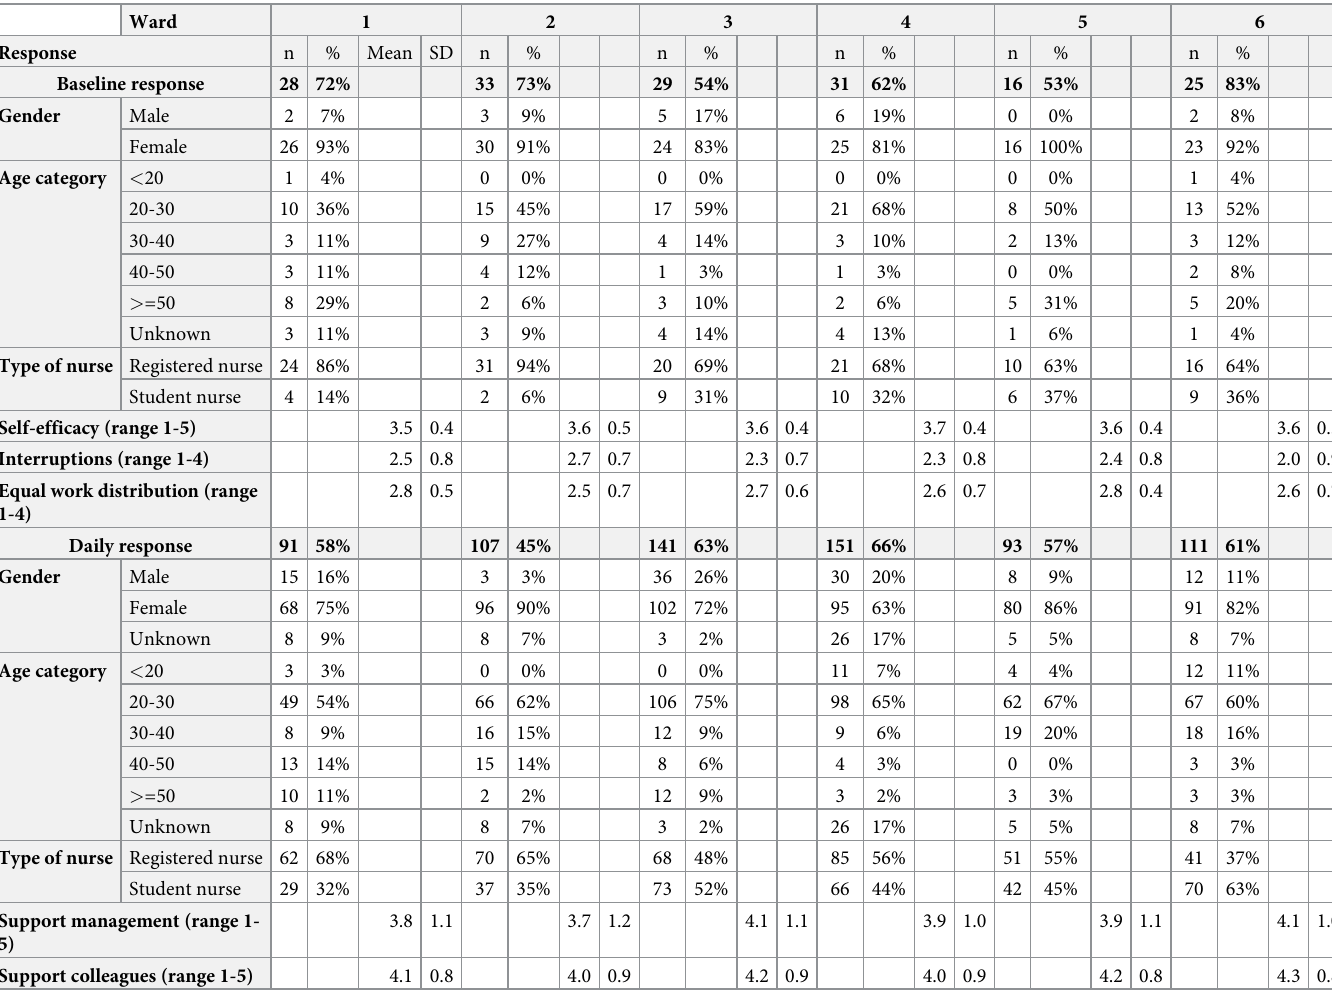
Table 1. Response rates, population characteristics and average response of the respondents of the baseline and daily questionnaires.